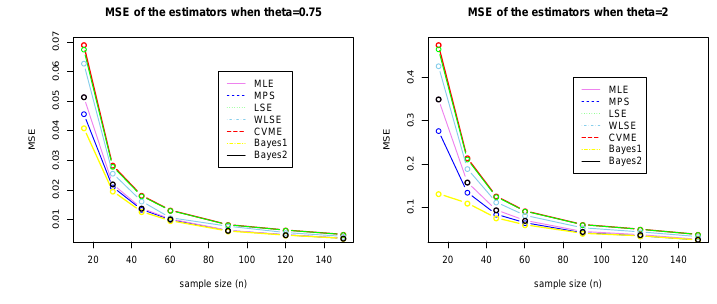
Figure 5 – Mean square error of the estimators obtained by